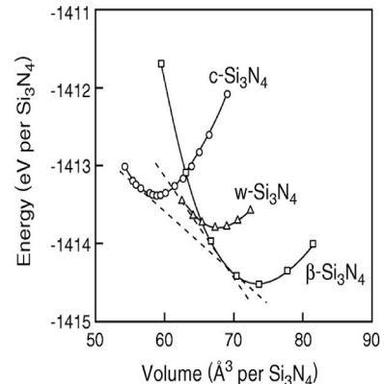
Calculated Gibbs energy-versus volume data for three Si3N4 polymorphs.